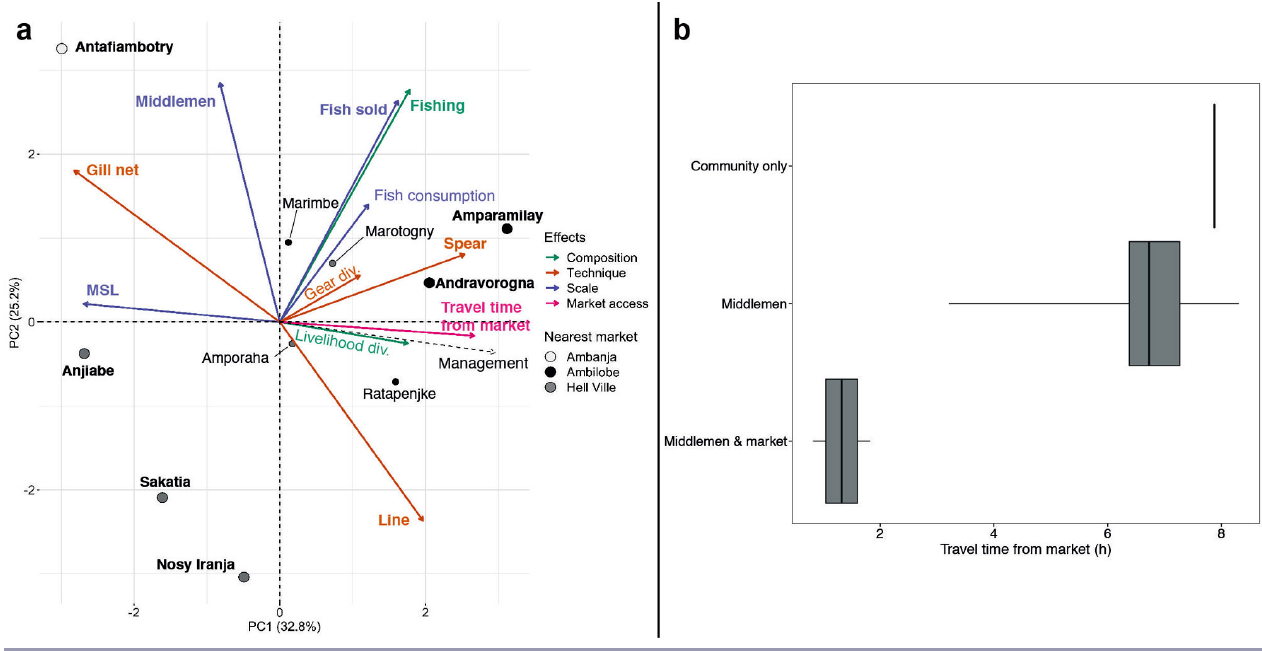
Fig. 3 . Associations between market proximity and (a) socioeconomic characteristics of communities through a principal components analysis and (b) selling strategies. (a) Ten socioeconomic indicators were assessed for each of the 10 coastal communities: the mean number of gear types (Gear div.), the proportion of fishing households who ranked gill nets (Gill net), spear (Spear), and line (Line) as main gear, the proportion of households who ranked fishing as primary activity (Fishing), the mean number of livelihood activities that households are involved in (Livelihood div.), a composite index of community wealth (MSL), the proportion of households consuming fish at least once a day (Fish consumption), the proportion of fish sold (Fish sold), and the importance of middlemen (Middlemen) in fish selling that were related to market access (Travel time from market). Social indicators were associated with the composition (green), the technique (orange), or the scale (purple) effect. Because market accessibility and management actions had confounding effects in the study area (marine reserves are disproportionately located far from markets) we included one supplementary variable (Management) to take into account this effect. The 10 coastal communities are represented as colored dots according to which nearest market they are associated with (Ambilobe: black; Ambanja: white; Hell Ville: grey) and are in bold when the community is well represented by the first two components (Cos2 > 0.4, see Appendix 5). Most variables were properly represented (in bold) by the two first components except fish consumption, livelihood, and gear diversity (see Appendix 5). (b) When fish sold, we also looked at the relationship between the preferred buyer: own community, middlemen from other communities, or local market and market access. At least part of fish catch was sold directly within the community, but fish was also sold to middlemen or at the local market. Middlemen were widespread in the region and seemed to buy seafood products from very close (< 2 hours) to more distant communities from markets (up to 8 hours). Distributions are represented using 95% confidence intervals when